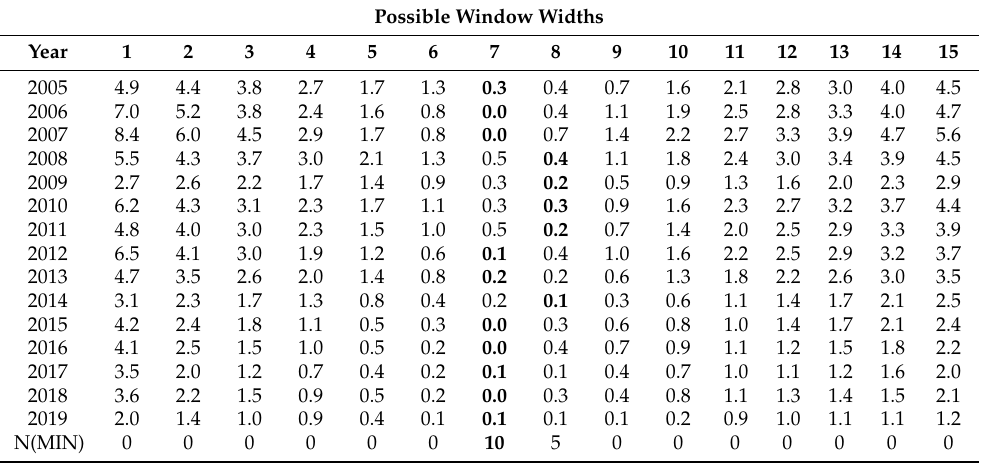
Table 4. Equation (2) results (absolute values) for all possible window lengths for the reference period 2005–2019.